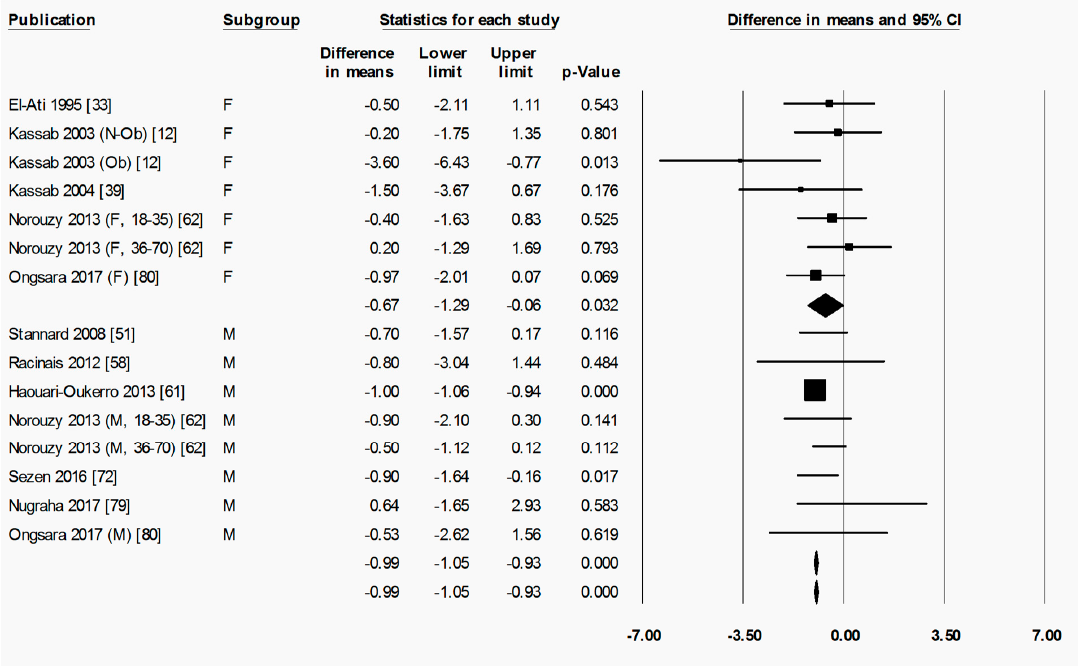
Figure 6. Absolute fat mass was significantly decreased by Ramadan fasting in both the female and the male subgroup. Change in absolute fat mass (kg) as subdivided by sex (female and male), between pre-Ramadan (pre-R) and the end of Ramadan (post-R). There was no significant difference between female and male subgroups ( p = 0.314). Heterogeneity statistics: female T = 0.298, p = 0.333, I 2 = 12.7%; male T = 0.000, p = 0.635, I 2 = 0.0%. F = female; M = male; Ob = obese; N-Ob = non-obese; 18–35, 36–70 = age range.